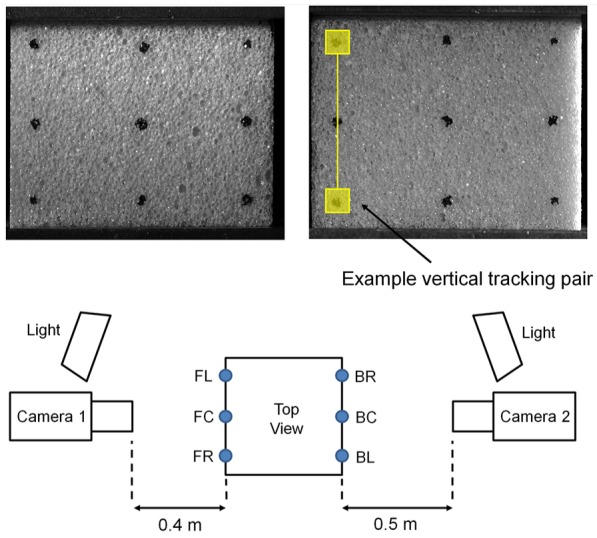
Marker arrangement and experimental schematic for optical extensometry.